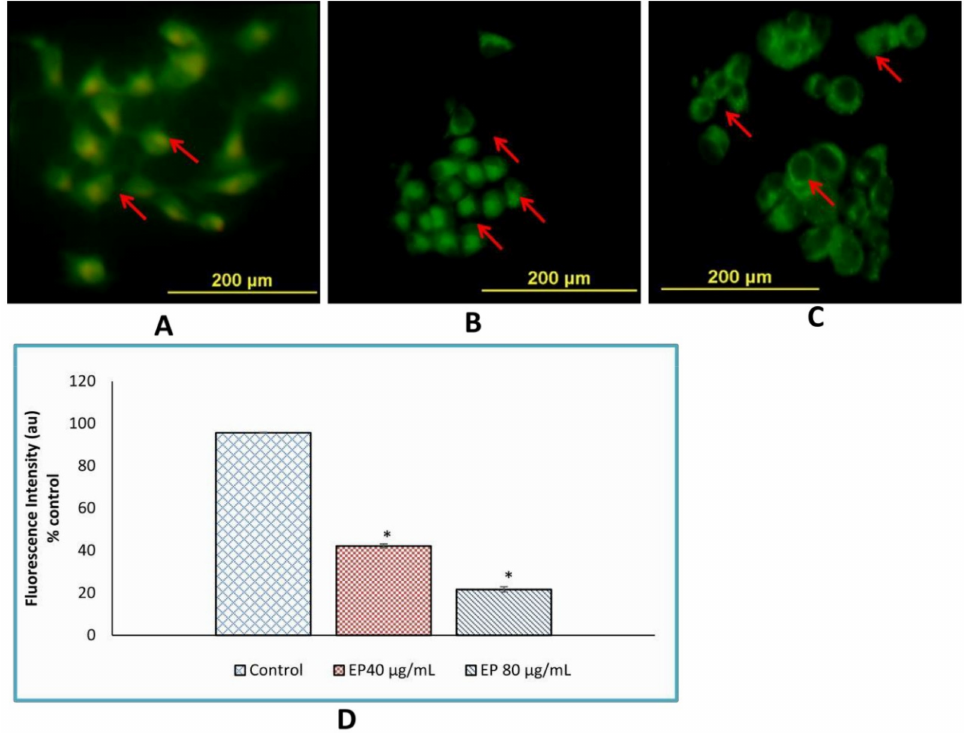
Figure 7. Effect of EP on mitochondrial membrane potential of MCF-7 cells. The cells were treated with ( A ) Control (untreated), ( B ) EP (40 µ g/mL), ( C ) EP (80 µ g/mL) for 24 h. After washing with PBS, incubated with rhodamine-123 dye (10 µ g/mL) for 30 min. ( D ) Percentage of cells showing fluorescence intensity after treatment with Fulvifomes sp. EP on MCF-7 cells. The percentage of cells that emit only green fluorescence indicates the depolarized mitochondrial membrane loss of membrane potential and orange-red fluorescence indicates polarized mitochondrial membrane. The values are represented as mean ± SD and three independent experiments were performed. * represents significant difference compared with control ( p <